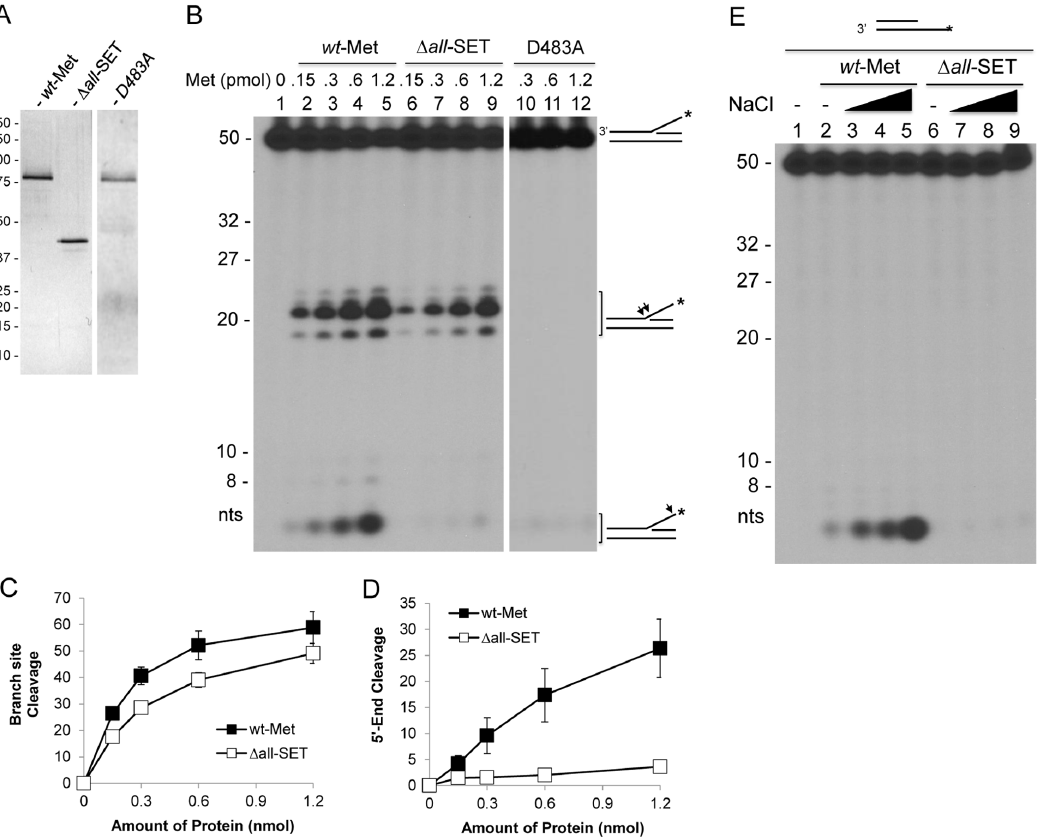
Fig 4. The Metnase SET domain is necessary for the 5 ’ -end cleavage of ss-overhang DNA. (A) Silver staining of purified wt-Metnase ( wt- MET), the SET deletion mutant ( Δ all -SET), and a nuclease-dead mutant (D483A) following 10% SDS-PAGE. (B) The SET domain is essential for cleavage of the 5 ’ -flap DNA. Reaction mixtures (20 μ l) containing the 5 ’ - 32 P-labeled flap DNA (60 fmol) and increasing amounts of wt -Metnase or the mutant ( Δ all -SET or D483A) were incubated at 37°C in the presence of 2 mM MgCl 2 for 90 min, and cleavage products were analyzed by 12% PAGE containing 8M urea. Numbers on the left indicated DNA size makers. (C-D) Cleavage of the branch site (panel C) and the 5 ’ end of ss-overhang (panel D) of a 5 ’ -flap DNA shown in Panel B was quantified using a PhosphorImager and ImageQuant software (Molecular Dynamics). (E) Cleavage of the 5 ’ end of the 5 ’ - 32 P-labeled partial duplex DNA with wt-Metnase and the SET deletion mutant. Indicated amount of wt-Metnase or the Δ all -SET was incubated with the 5 ’ - 32 P-labeled ( * ) 5 ’ -ss-overhang DNA (60 fmol) for 90 min at 37°C prior to 12% PAGE analysis (+ 8M urea). Arrows on the right mark the cleavage sites on the 5 ’ - 32 P-labeled ( * ) DNA.